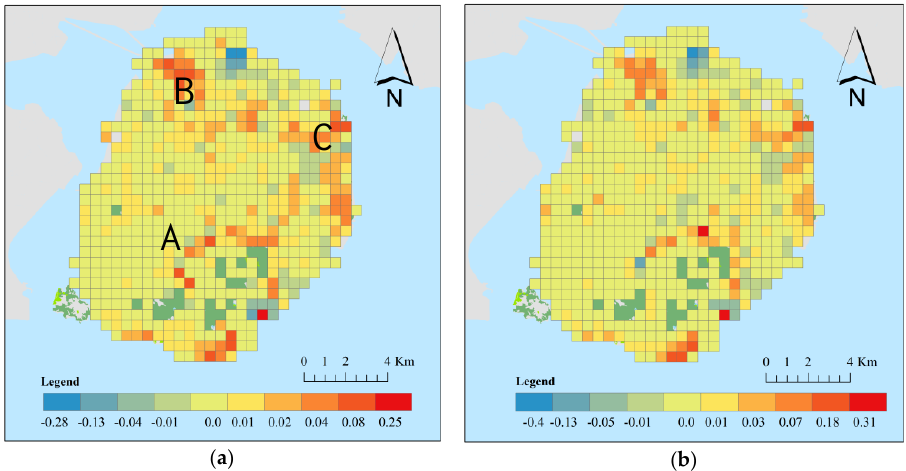
Figure 8 . Spatial distribution of the coefficients of ‘residential density’. ( a ) GWR; and ( b ) GTWR. Region A has the highest density of residential buildings. Regions B and C are two newly developed zones.